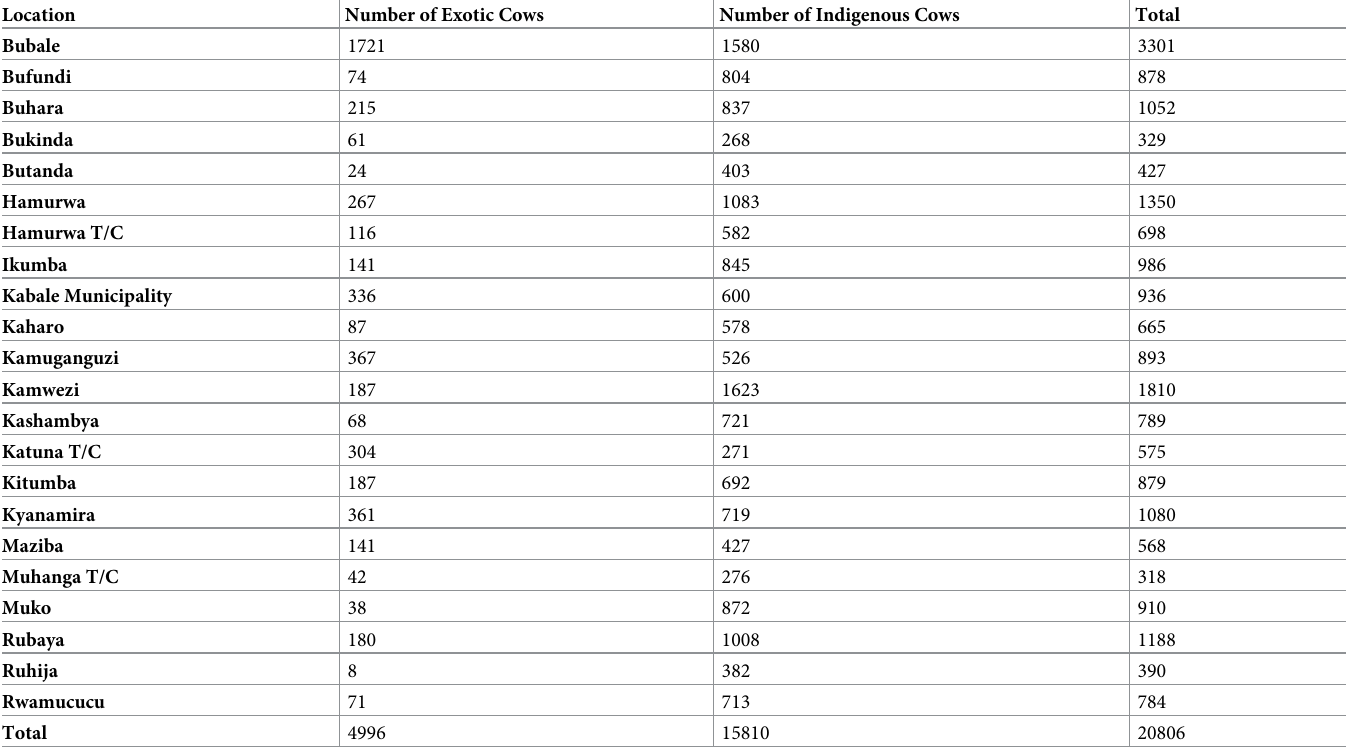
Table 1. Cows in different locations in the Kabale District; this data set was derived from the UBOS Statistical Report 2012, Kabale District [24]. Location Number of Exotic Cows Number of Indigenous